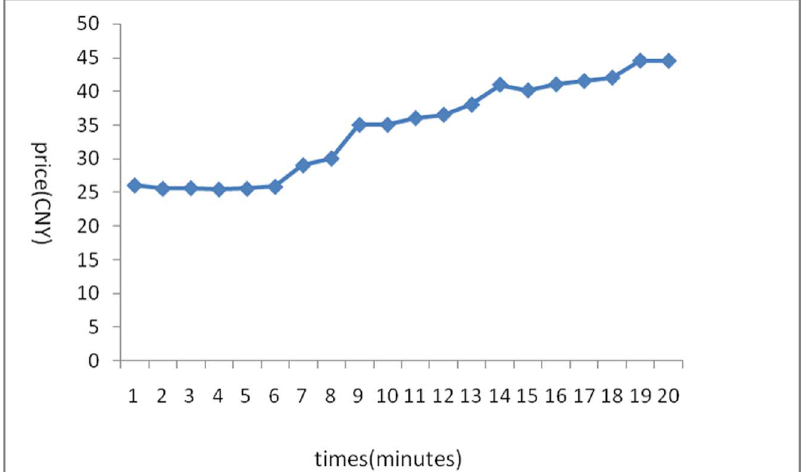
Figure 2. Second Experiment of a Unilaterally Price-Rising Situation with Manipulation.